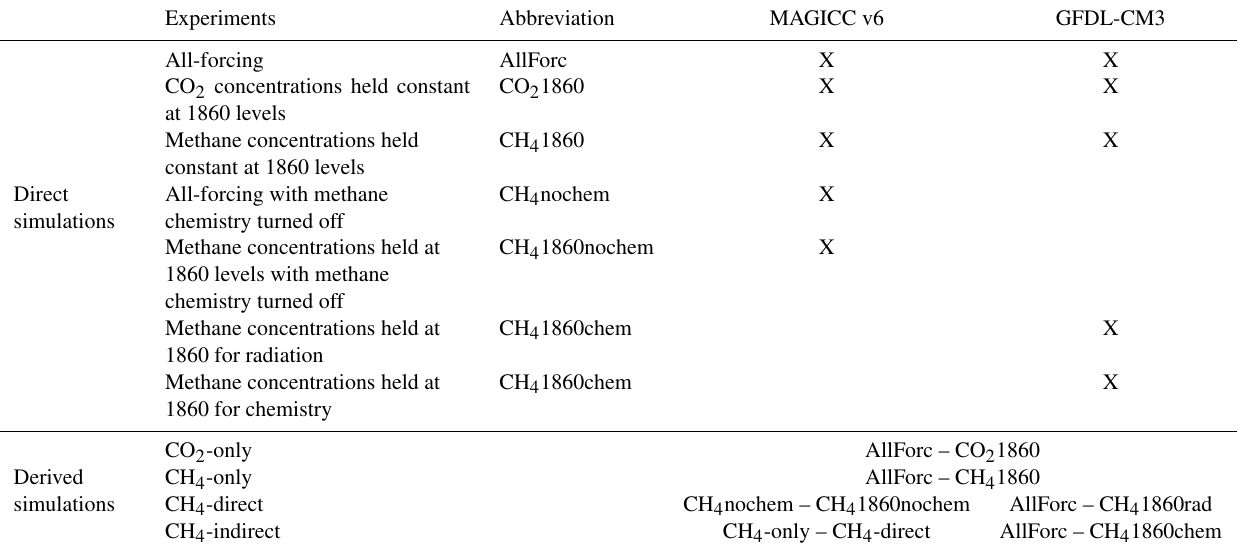
Table 1. Direct experiments performed by MAGICC and GFDL-CM3 models, as well as derived simulations. All-forcing simulations include time-varying natural and anthropogenic forcings, but land use is held constant. Each experiment is run for 19 physics-driven ensemble members for MAGICC and 3 initial condition-driven ensemble members for GFDL-CM3 over the period